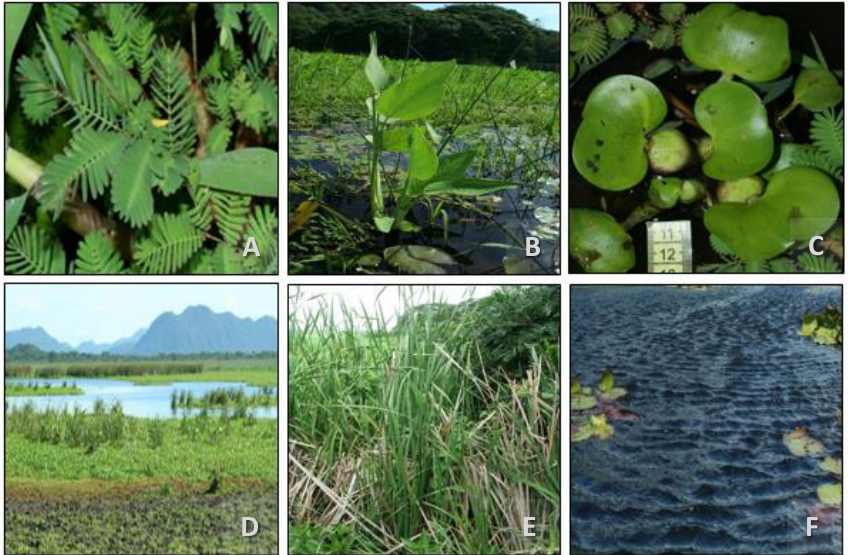
Figure 3. Pictures of the selected wetland covers. ( A ): Neptunia natans ; ( B ): Thalia geniculata ; ( C ): Eichhornia crasipes ; ( D ): species mix (Mixed); ( E ): Typha dominguensis ; ( F ): Open